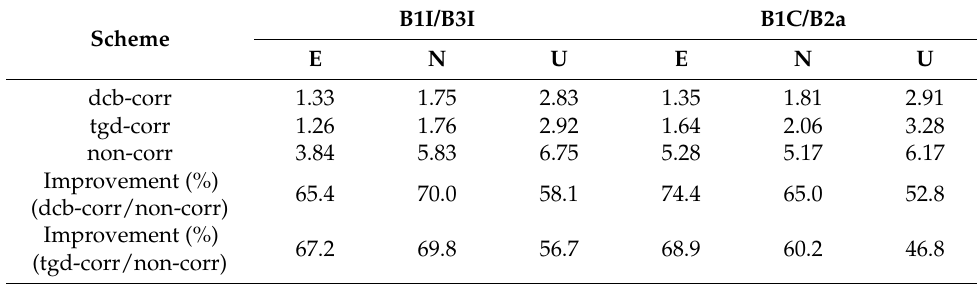
Table 5. RMS in BDS-3 dual-frequency SPP performance with different schemes